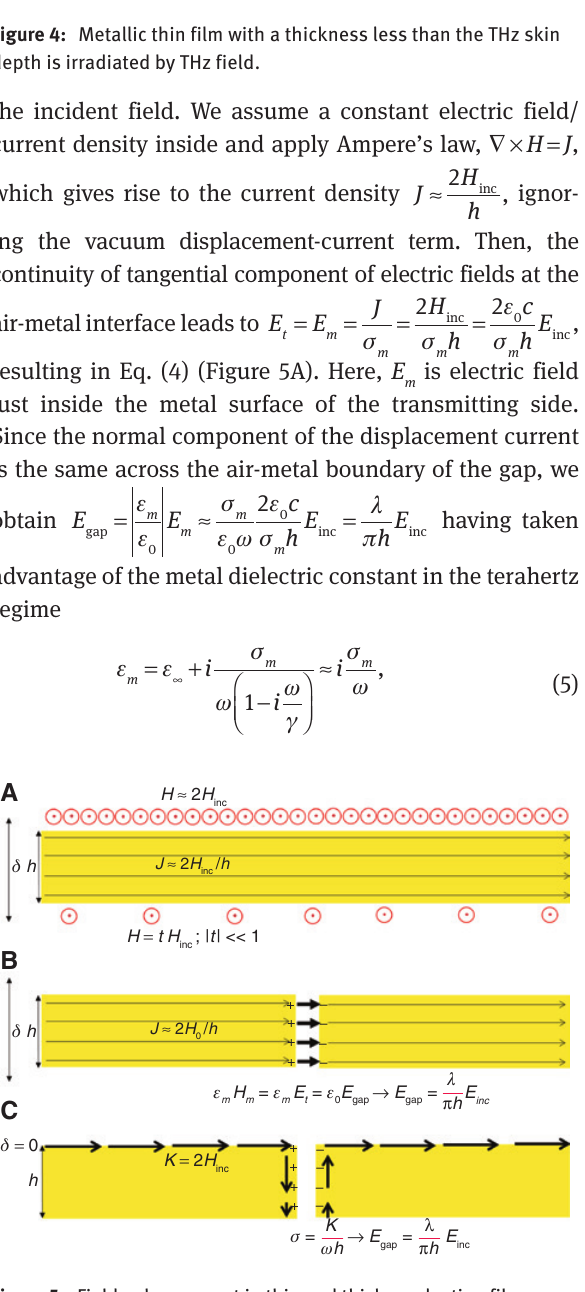
Figure 5: Field enhancement in thin and thick conducting films. (A) Magnetic field of light and current density near the thin film is represented in red, where THz impinges to the plane. The magnetic field is approximately twice at the incident surface (up) and much smaller at the transmission side (bottom). (B) Obtained displace- ment current and E around the narrow gap. (C) Displacement gap current and E at films much thicker than the skin depth. gap